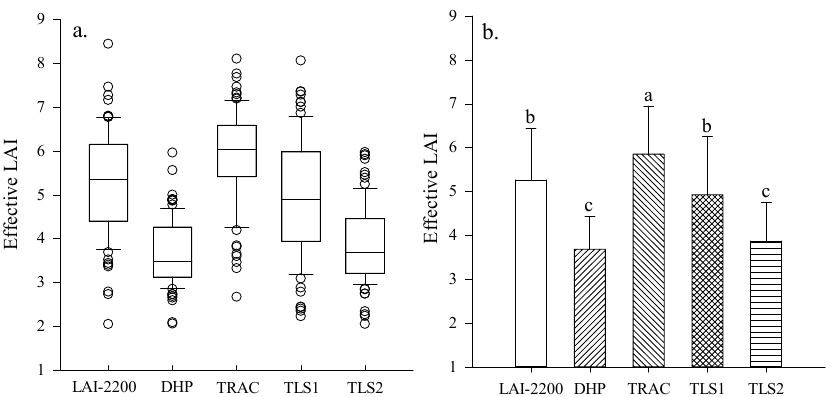
Figure 4. The difference of effective LAI estimated by different indirect methods. ( a ) Box plots, the central line in the box indicates the median, and the bottom and top edges indicate the 25th and 75th percentiles. Outliers are plotted using the “ ○ ” symbol; ( b ) Estimating performance (Mean ± SD). Different lowercase letters (a, b, or c) indicate significant differences between the effective LAI estimated by different methods ( p < 0.05). TLS1 indicates TLS multi-station, and TLS2 indicates TLS single-station. Table 2. Correlation coefficients of estimating the effective LAI by different indirect